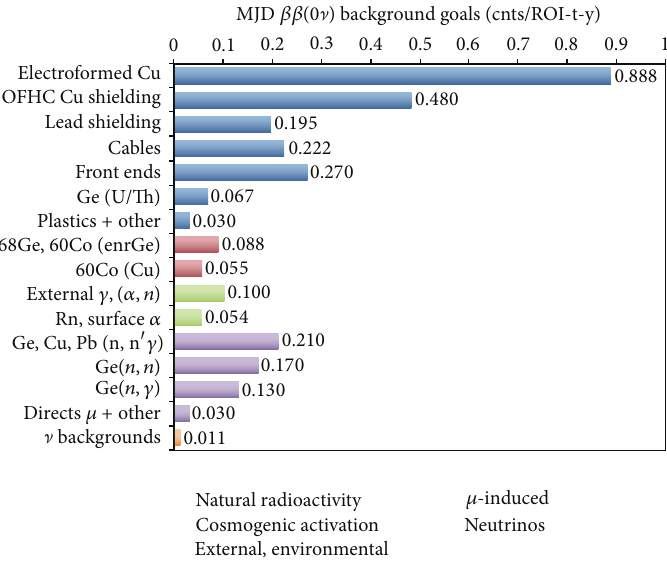
Figure 13: Estimated background contributions for the 𝛽𝛽(0 ] ) -decay search. Backgrounds from natural radioactivity are shown in blue. Cosmogenic activation products are colored red. Green denotes backgrounds from the environment or those introduced during detector assembly. Purple is for 𝜇 -induced backgrounds at depth. An upper limit on the negligible background from atmospheric and other neutrinos is shown in orange. The contributions sum to 3.0 cnts/(ROI-t-y) in the Majorana